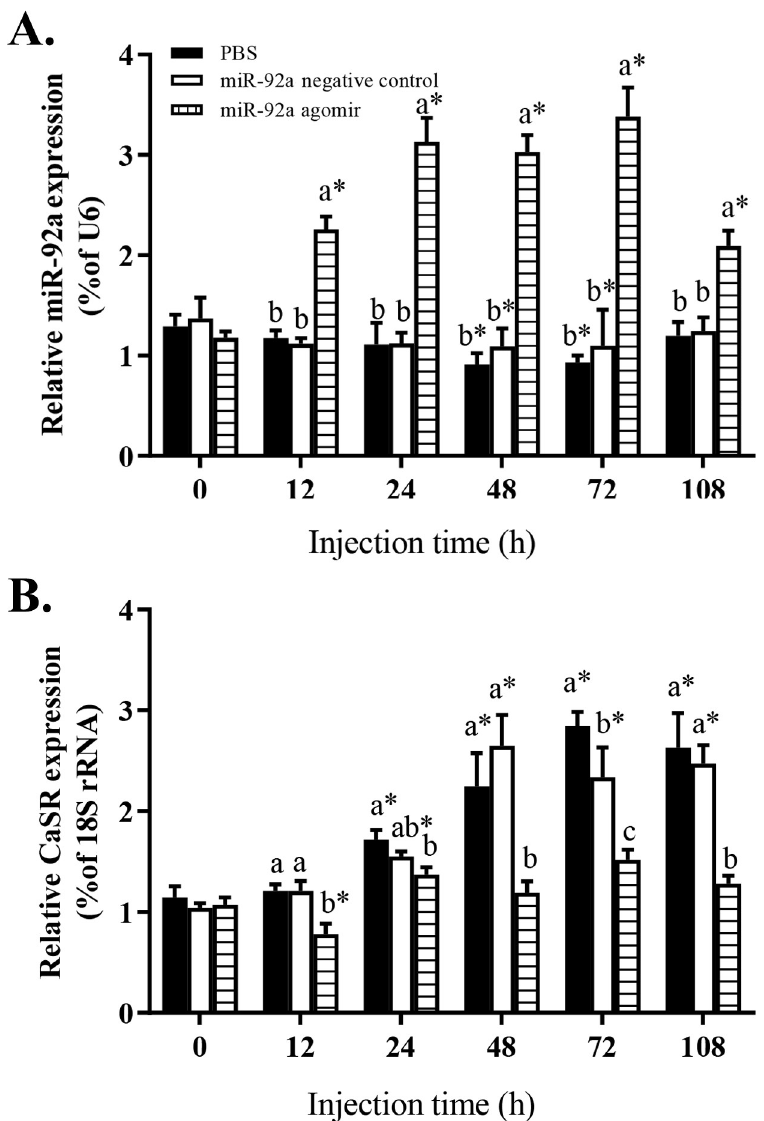
Fig 5. Effect of promoting miR-92a expression on transcript levels of miR-92a (A) and CaSR (B) in GIFT liver. Juveniles weighing 26.8 g ± 0.9 g were injected in tail vein (dose, 25 mg/kg body weight) with miRNA negative control, or miR-92a agomir, or PBS (control) and response was monitored for 108 h. Based on relative expression levels in control group at 0 h, relative expression levels of mRNA and miRNA in each experimental group were determined by 2 - ΔΔ CT method. � Indicates significant differences between pre- and post- injection in the same experimental group (Independent samples t test; P < 0.05). Different lowercase letters indicate significant differences among different treatments at each sampling point (Duncan’s multiple comparison; P <